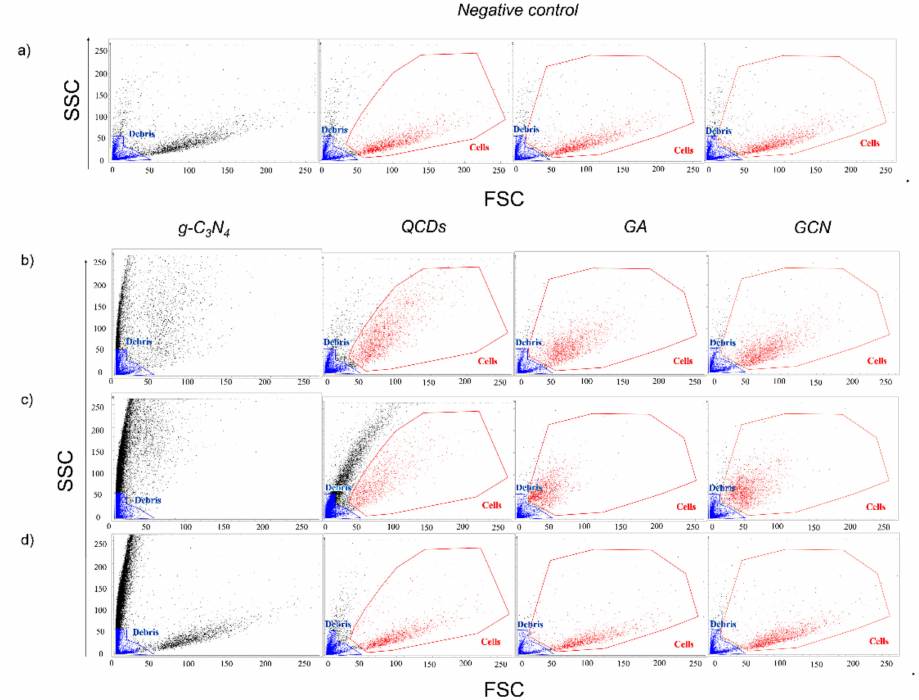
Figure 2. Forward and side scatter profiles for samples: ( a ) negative control of BJ cells (4 × same sam- ple with specific gates for each NMs); BJ cells treated for 24 h with ( b ) 50 µ g/mL and ( c ) 300 µ g/mL of carbon nanomaterials and ( d ) spike-in controls (from left to right: g-C 3 N 4 , QCDs, GA and GCN). The population of cells is highlighted in red, the population of debris is marked blue and the remaining black population in samples g-C 3 N 4 and QCDs is considered NMs